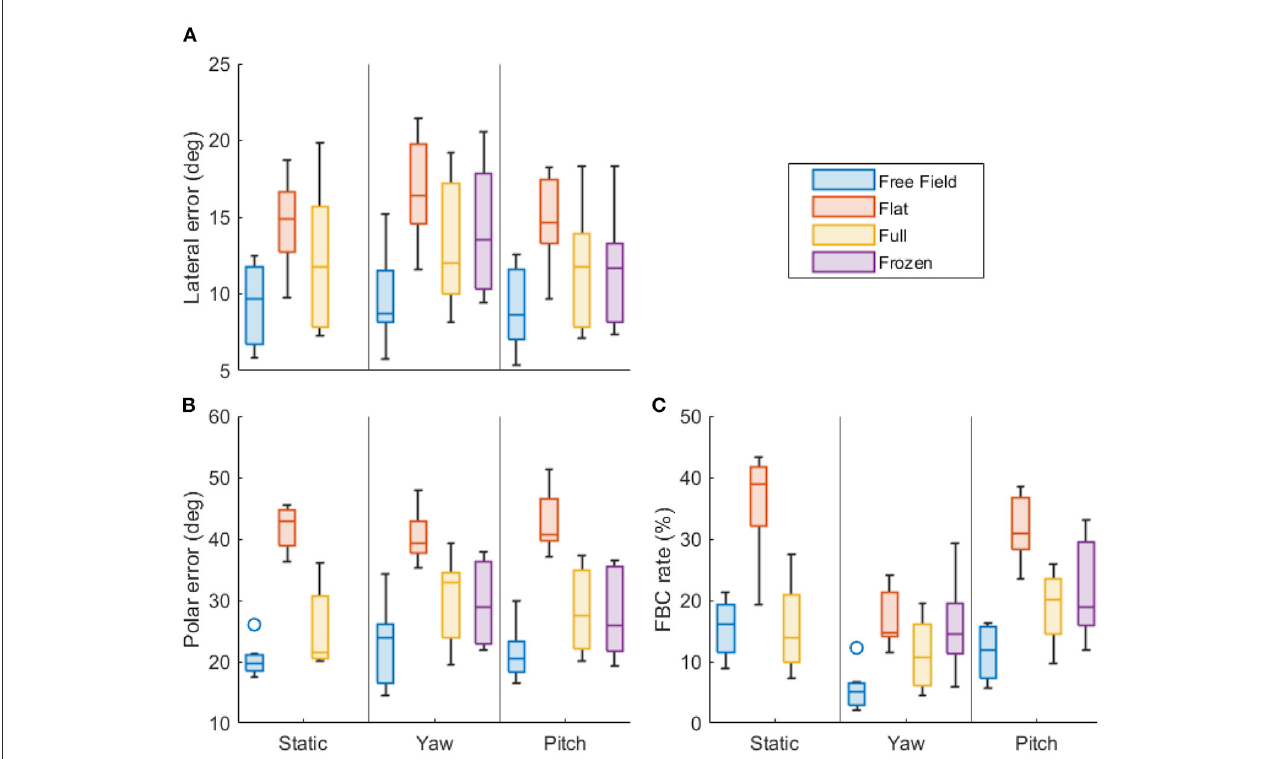
FIGURE4 Localization performance grouped by the type of head rotation. (A) Lateral precision error (in degrees). (B) Polar precision error (in degrees). (C) Front-back confusion rate (in %). Lower values indicate better performance. Each boxplot shows the statistics of all subjects (median, first and third quartiles, minima and maxima,